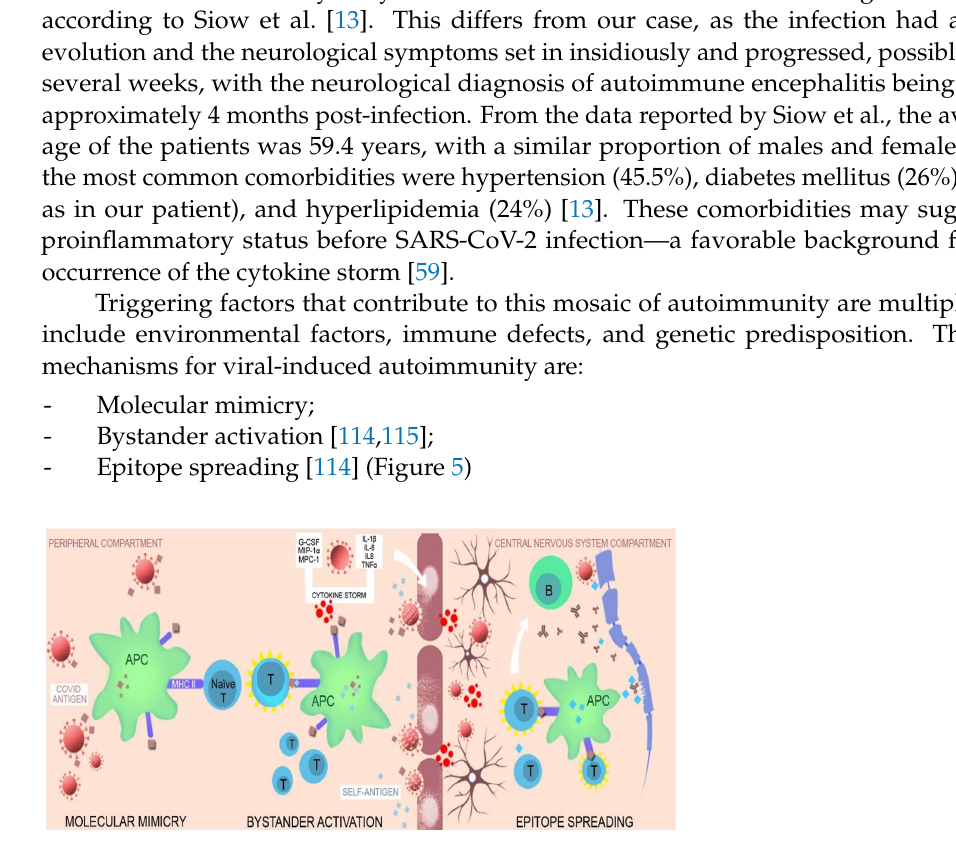
Commented [M4]: 图 5 截图了，把之前图中的文 Figure 5. Graphical representation of the proposed mechanisms for viral induced autoimmunity.